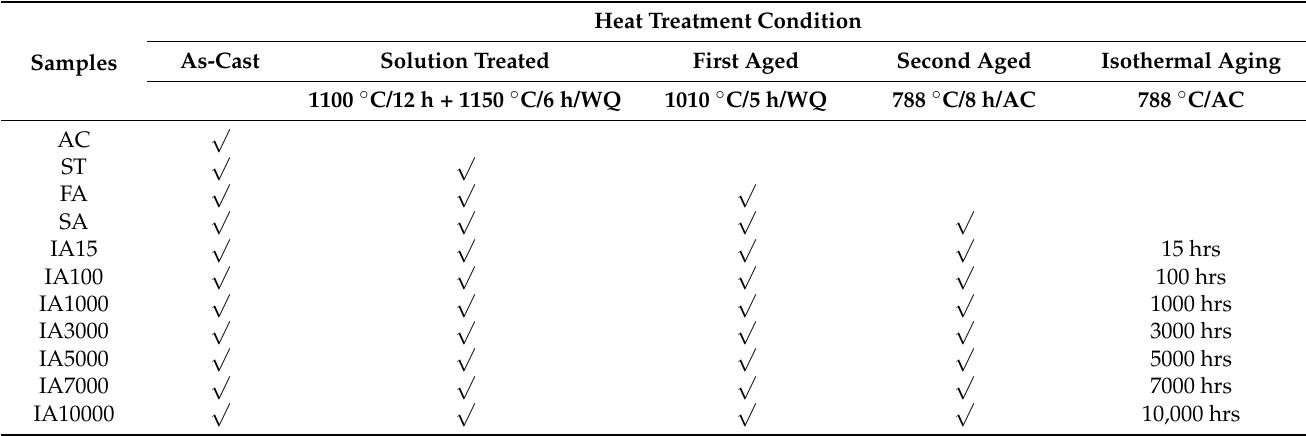
Table 2. Conditions and code names of all the samples in this paper (WQ: water quenching; AC: air cooling; the sample was undergone this heat